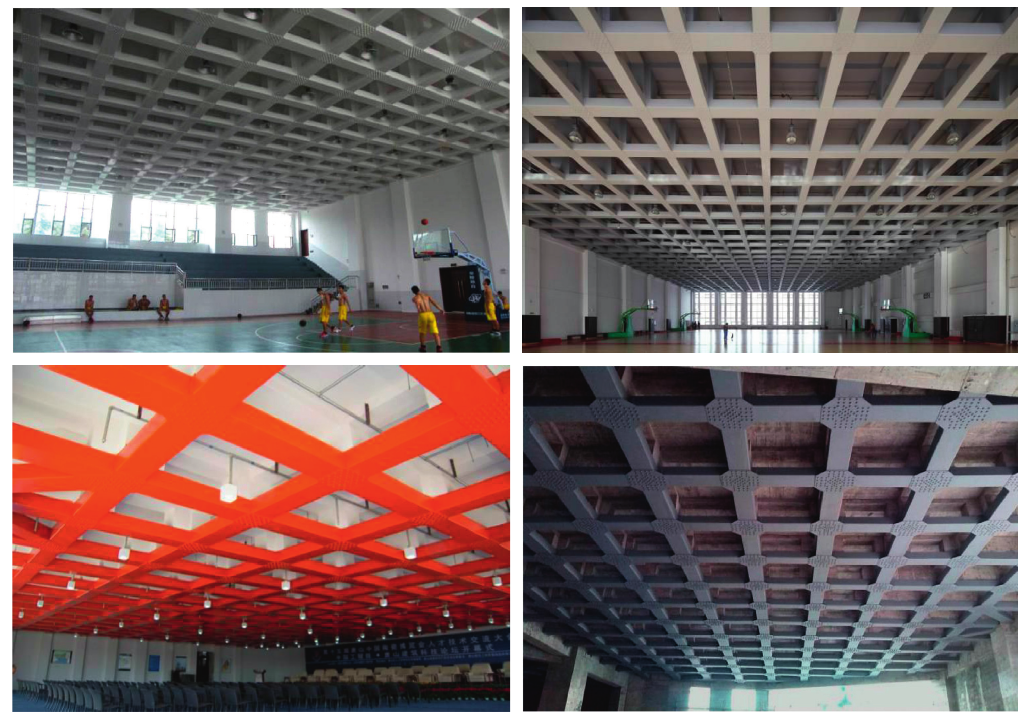
Figure 2: Engineering